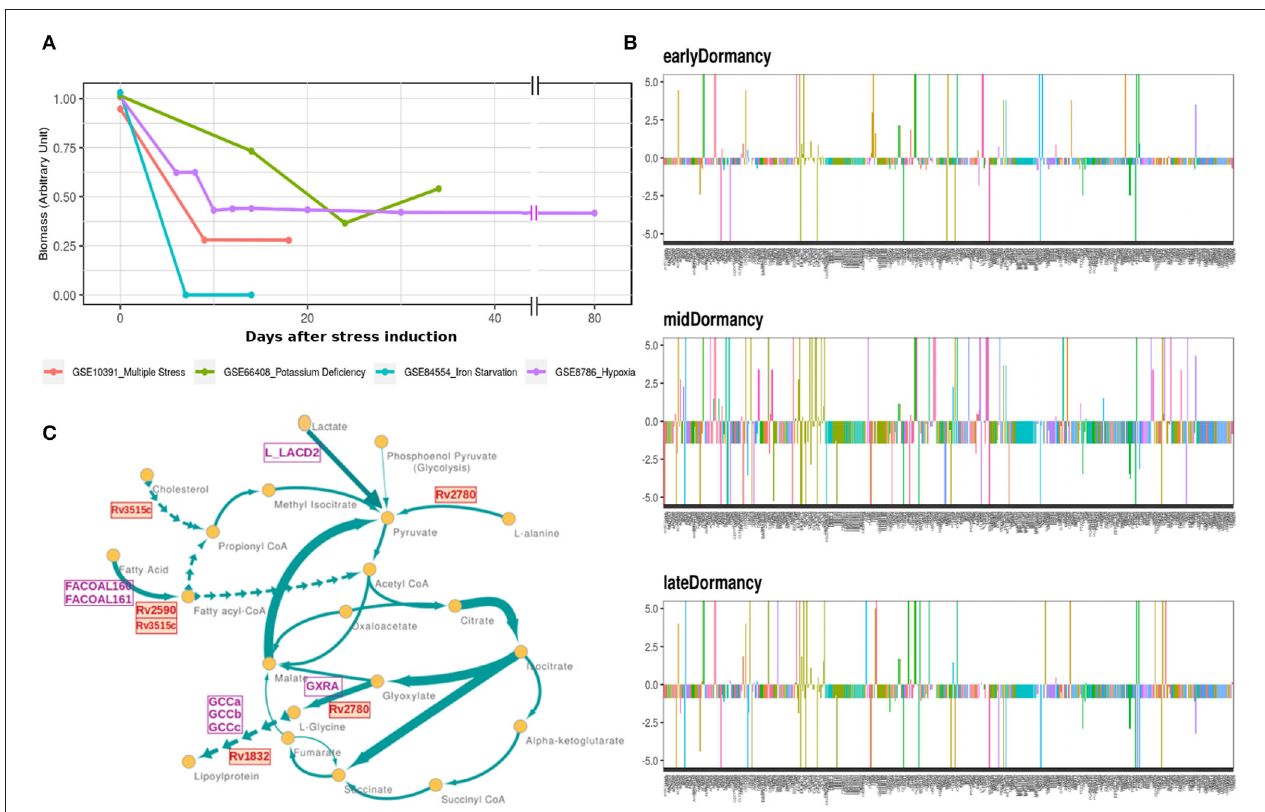
FIGURE 3 | (A) Optimal flux through the hypothetical biomass reaction from iEK1011 in different timepoints of all the models showing a significant reduction in biomass generation in dormancy compared to exponential growth. (B) Flux fold change of all non-zero reactions in Potassium deficiency model of dormancy at 3 different stages in comparison to the exponential growth phase. X axis in each contains the reactions with non-zero fluxes and Y axis shows the fold change value. Most of the reactions are downregulated during dormancy. (C) A representative subgraph of metabolic pathways focused on the TCA-glyoxylate cycle of central carbon metabolism in dormant state Mtb in multiple stress induced model. The thickness of the edges is directly proportional to flux through the reactions. Yellow circles signify metabolites. Purple squares indicate reactions from the 14 commonly upregulated reactions across dormancy models. Red squares highlight the genes eventually identified as drug target candidate further down the pipeline.